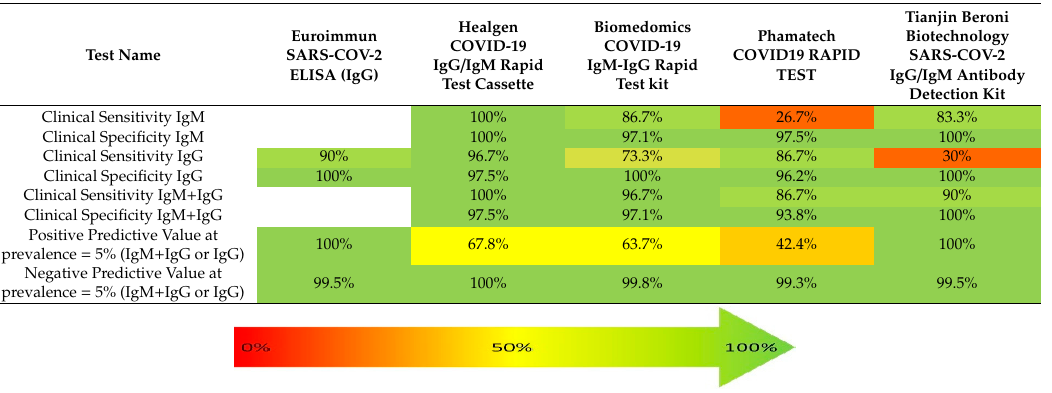
Table 6. Evaluations of Coronavirus Disease 2019 (COVID-19) serological tests, including sensitivity, specificity, and predictive value [31] (updated 13 June 2020, online sources according to manufacturers’ pecification).